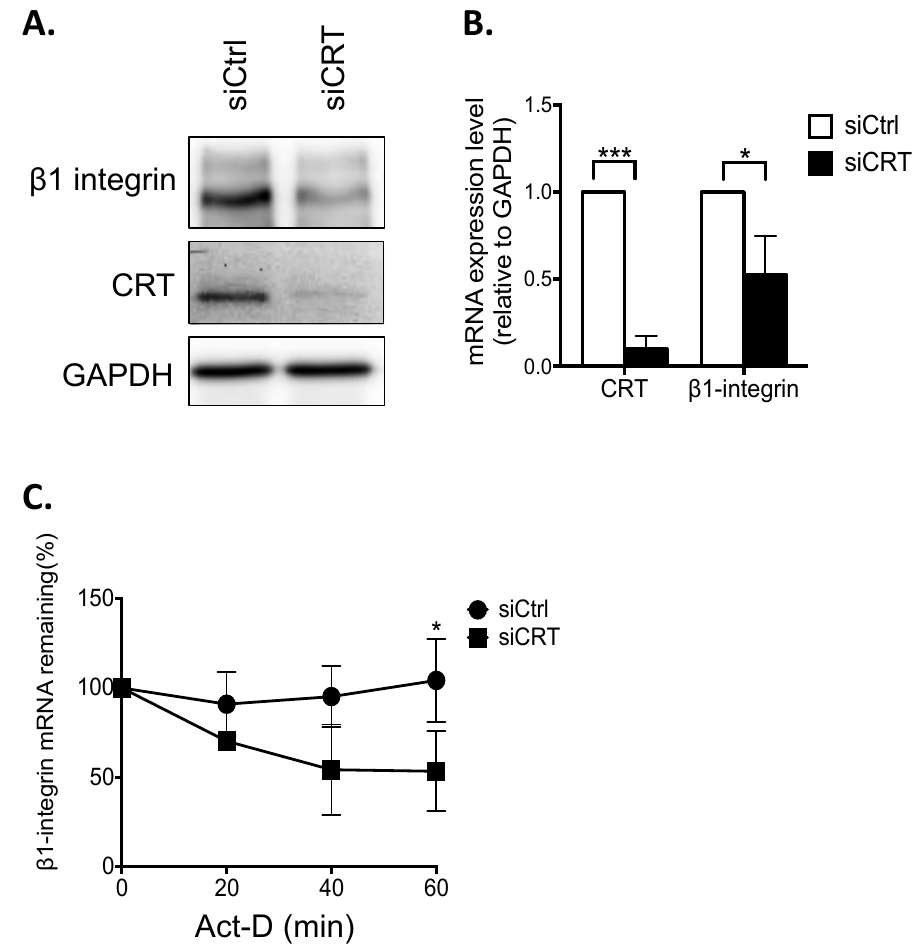
Figure 1. Knockdown of CRT decreases β 1-integrin expression in PC-3 cells. ( A ) Western blot of CRT, β 1-integrin, and FUT-1 protein expressions in PC-3 cells transfected with CRT (siCRT) and control siRNA (siCtrl) for 48 h. GAPDH was used as the internal control. ( B ) Real-time PCR analysis of mRNA expressions of CRT and β 1-integrin in PC-3 cells transfected with siCRT and siCtrl for 48 h. ( C ) siCtrl and siCRT-transfected cells were treated with 2.5 μ g/mL actinomycin (Act-D) for 0, 20, 40, and 60 min, and total RNA were harvested. The relative mRNA levels of CRT, β 1-integrin, and VEGF-A were normalized to the internal control GAPDH. Results are shown as means ± SD. All the experiments were repeated at least three times. * p < 0.05; *** p < 0.001.